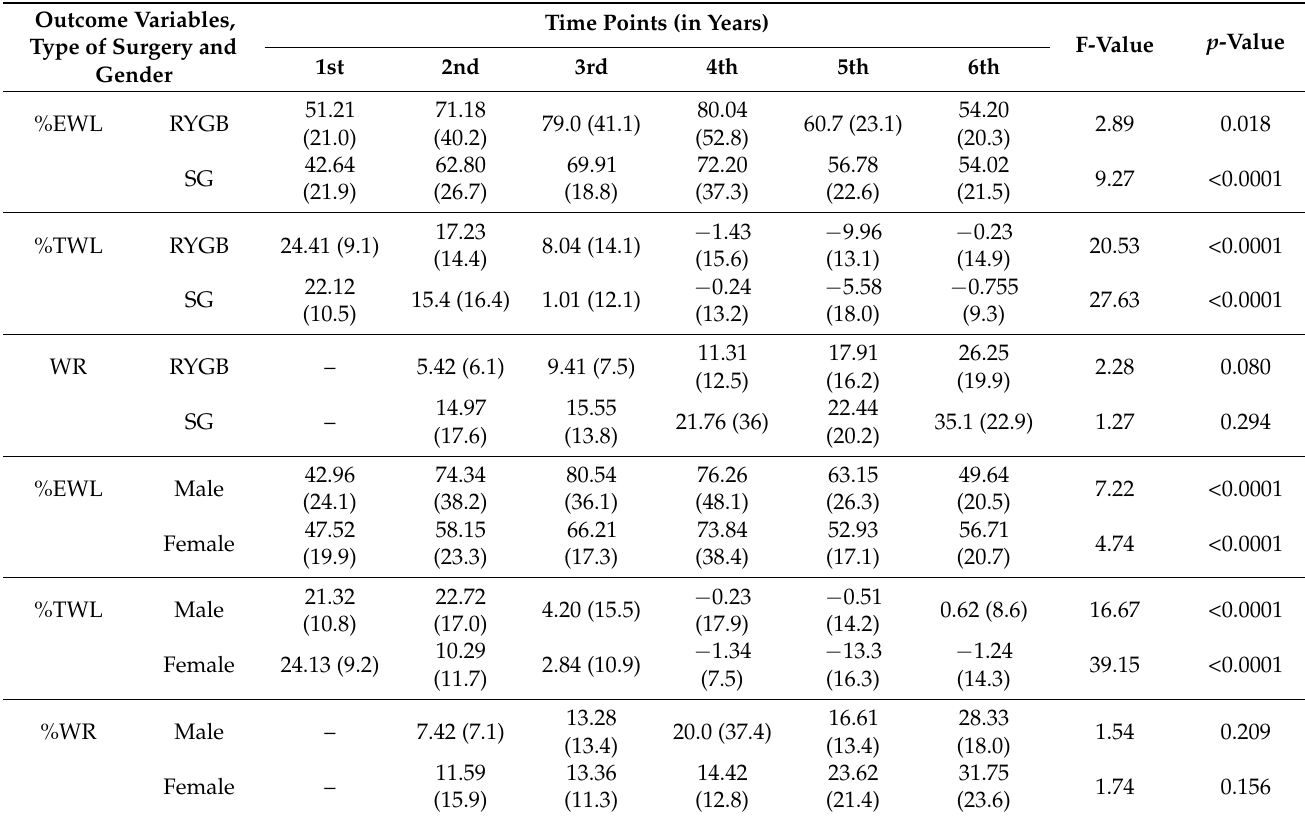
Table 3. Comparison of repeated measure (%EWL, %TWL, and %WR) mean values across the six time points in male and female subjects and in relation to type of